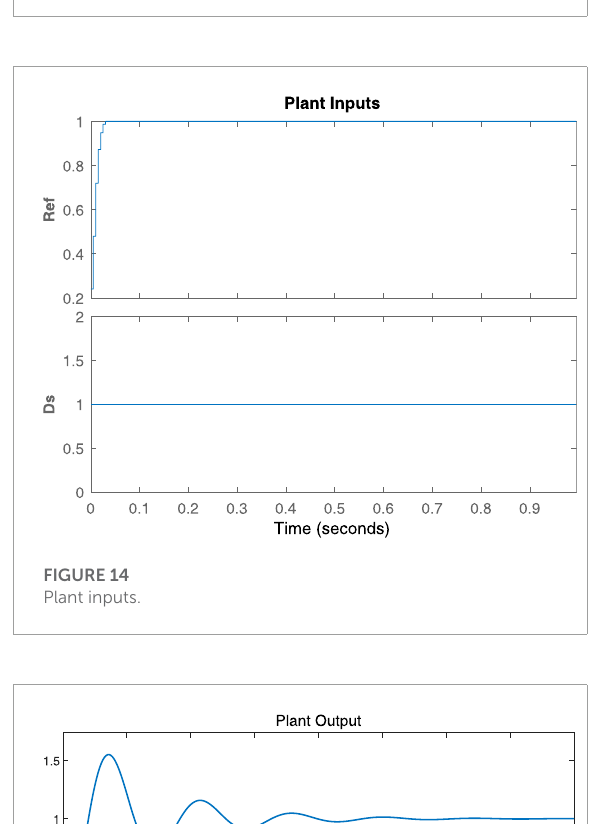
FIGURE 13 Plant output using MPADRC.